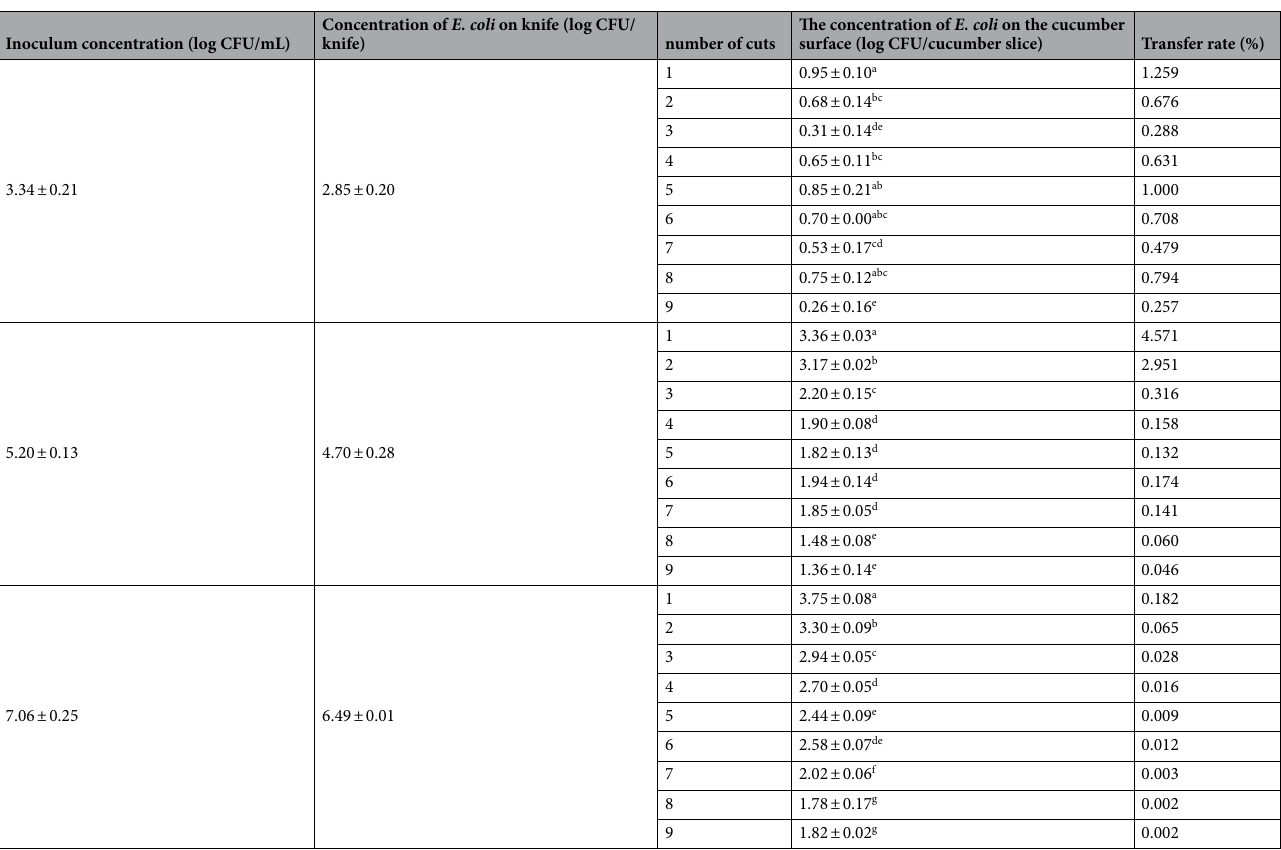
Table 2. The transfer of E. coli from the kitchen knife to the cucumber surface. Different letters in the same column indicate statistically significant differences ( p <